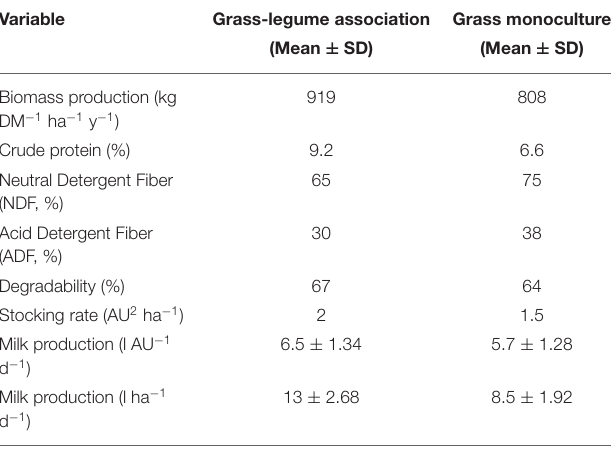
TABLE 1 | Animal response data for the grass-legume association and grass monoculture.